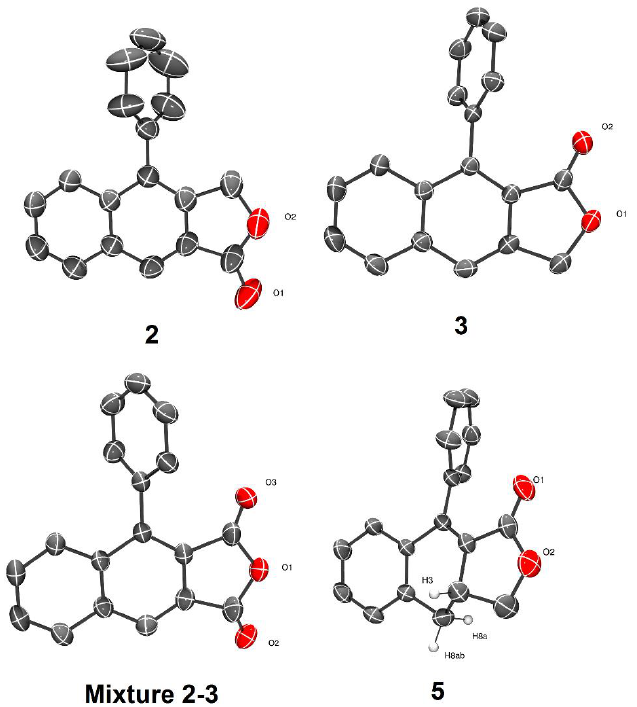
Figure 1. Molecular structures (50% ellipsoids) of 2 , 3 , mixture 2 – 3 and 5 . All H atoms are omitted for clarity except for 5 , which can be found and refined. Selected bond lengths [Å]: C = O: 1.199(2) ( 2 ), 1.1917(17) ( 3 ), 1.091(3), 1.136 (3) ( mixture 2 – 3 ) and 1.2010(16) ( 5 ). Color scheme: O: red, C: gray and H: grey.